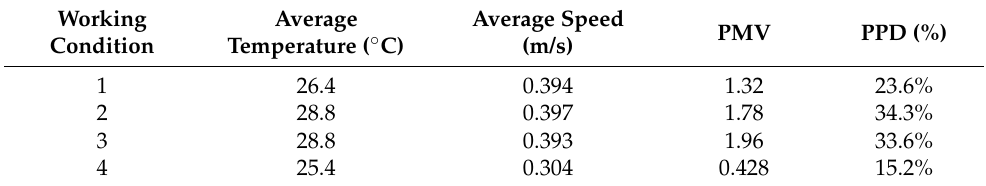
Table 7. Summary of the average value of calculation parameters at the working area under different working